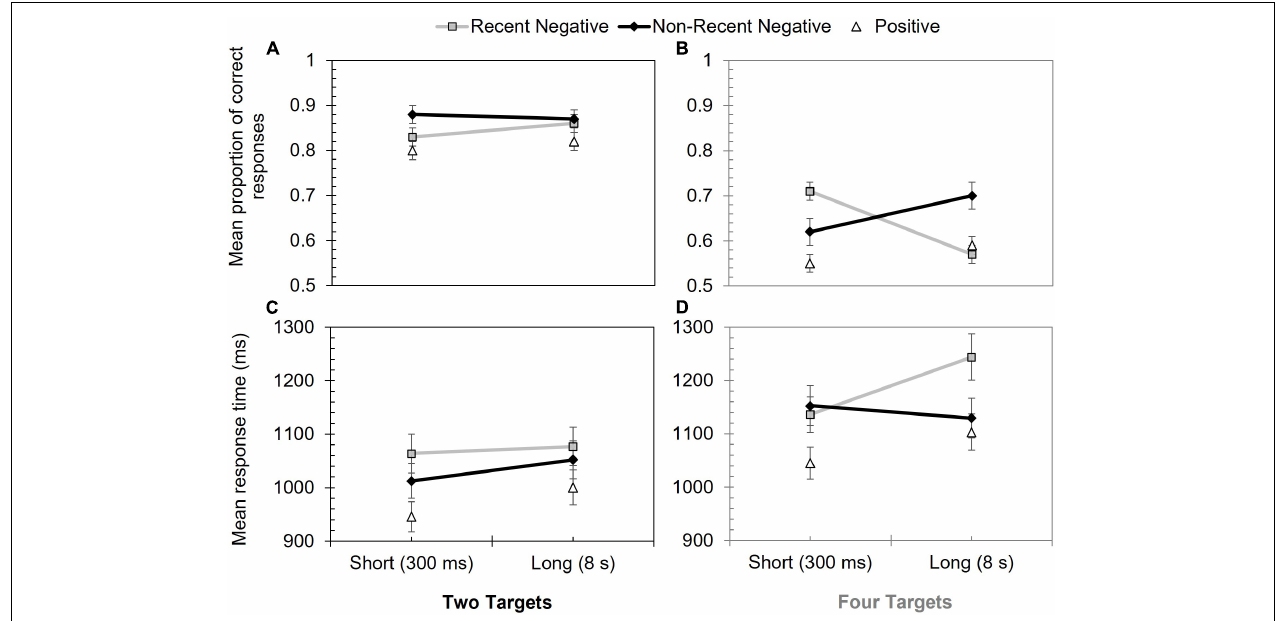
FIGURE 2 | Performance in Experiment 1 according to probe type, inter-trial interval, and array size. Panels (A,B) show mean proportion of correct responses for two and four targets, respectively. Panels (C,D) show mean response time (ms) for two and four targets, respectively. Error bars show +/–1 SE.